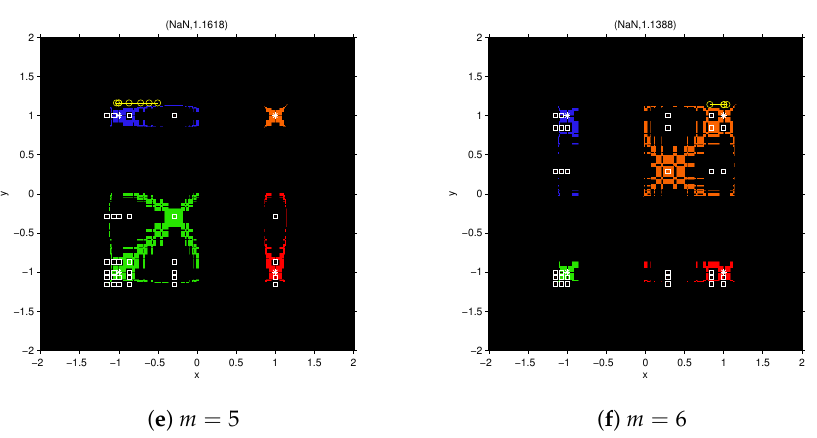
Figure 3. Dynamical plane of FMN m method for m = 1,2, . . . ,6 on r ( x ) . Green, orange, red and blue areas are the basins of attraction of the roots of q ( x ) (marked as white stars); black area denotes divergence and white squares are free critical points.